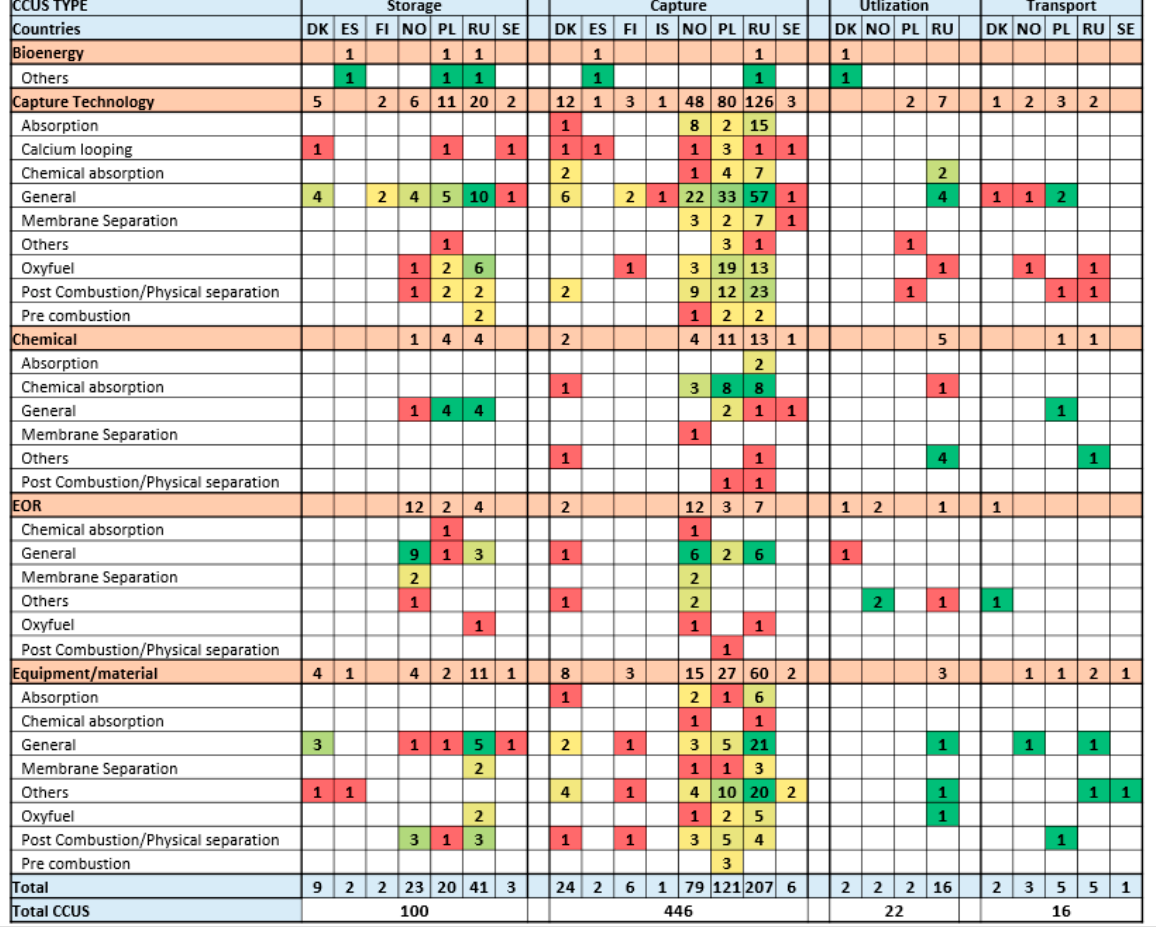
Figure 14. Technology focus (Primary)—countries. The figure uses two colors to represent high and low numbers i.e., the more green represents a higher number and more red indicates a lower figure in each of CCUS types and technology.